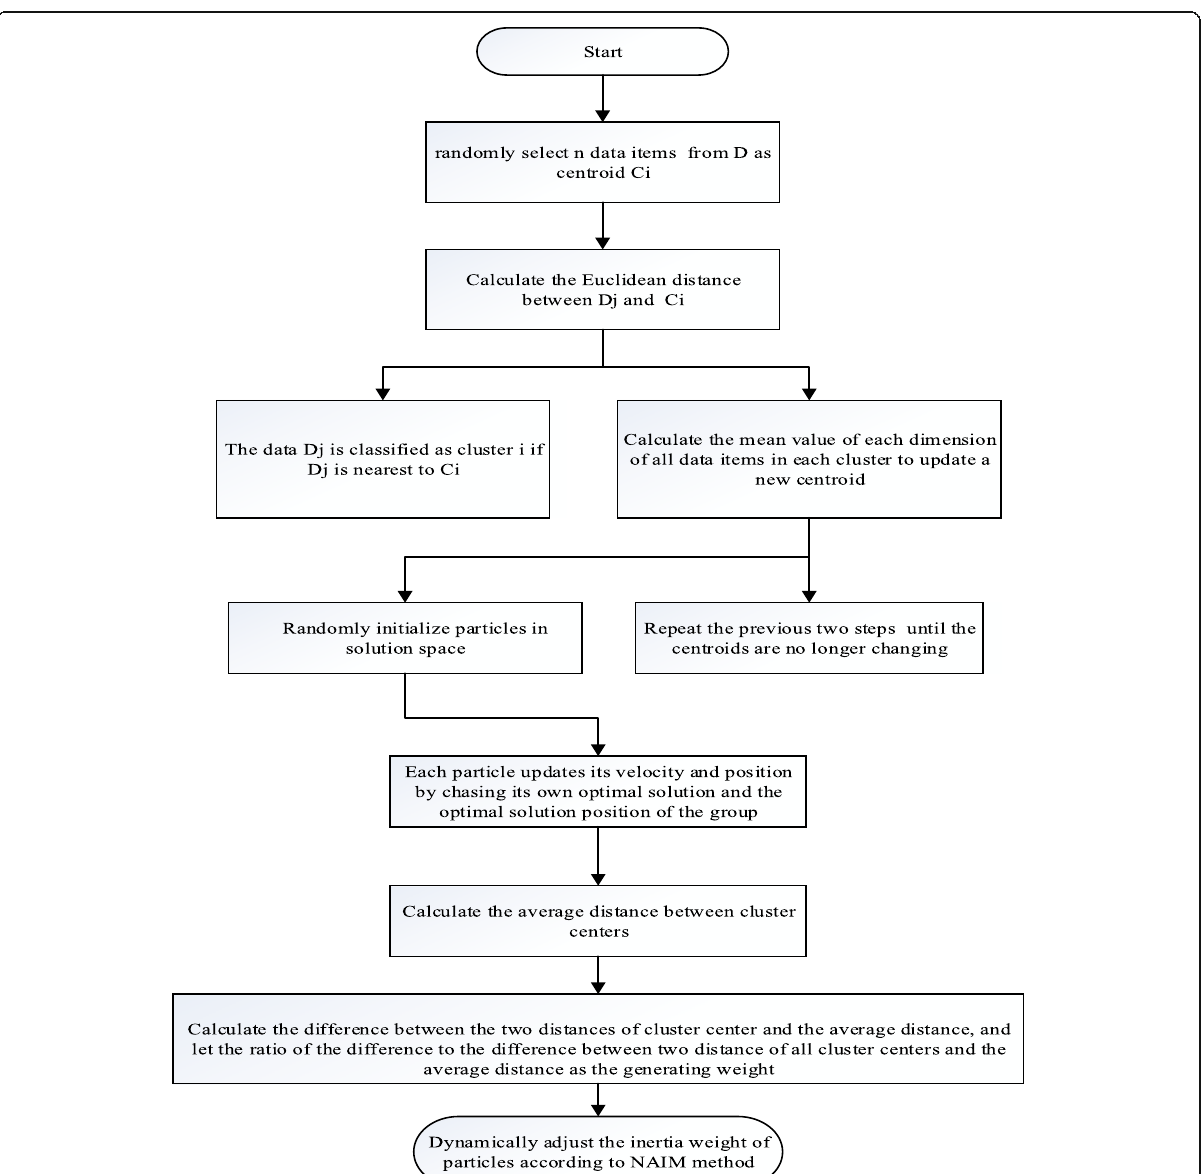
Fig. 3 Flow diagram of the algorithm to extract the optimal external middle